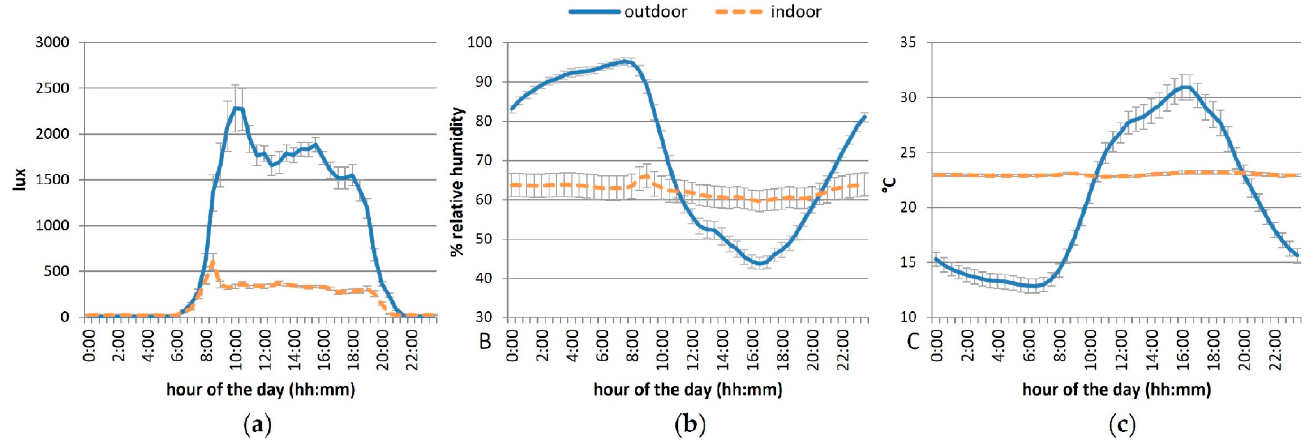
Figure 2. Mean daily luminosity (lux, a ), ambient temperature ( ◦ C, b ) and relative humidity (%, c ) ac- cording to the housing condition (indoor versus outdoor). Error bars represent standard